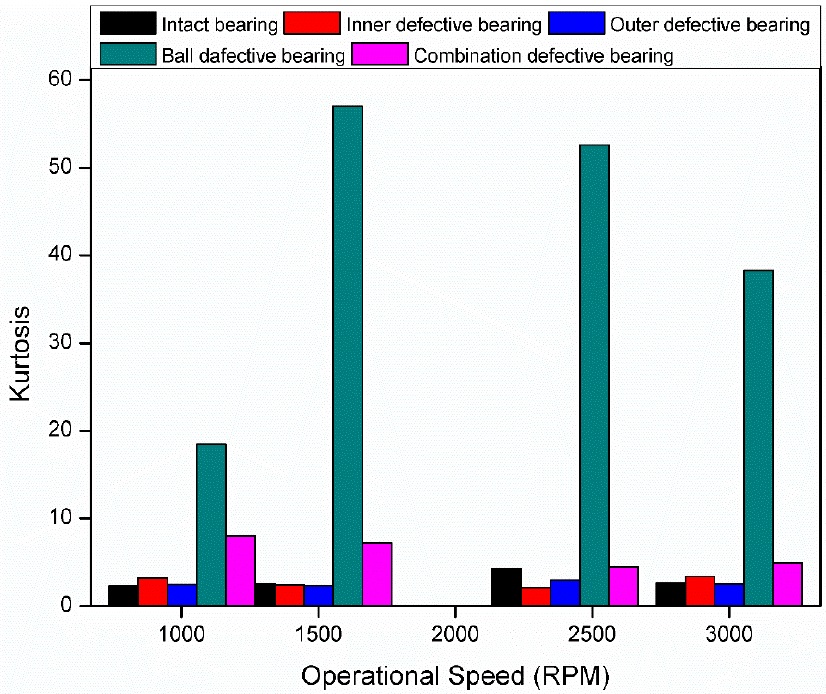
Figure 11. Comparison of averaged kurtosis values with installing a bearing loader.